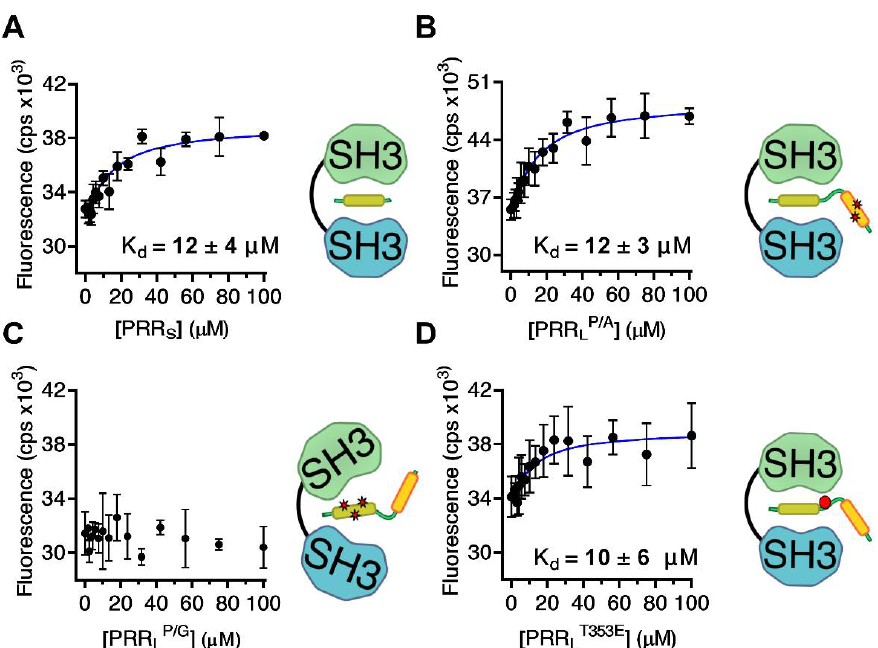
Figure 4. Binding of truncated and mutant PRR fragments to the SH3 1 –SH3 2 domain of Tks4. Dissociation constants were determined via tryptophan fluorescence-based titration experiments. PRR S ( A ) is a truncated form of PRR L . In PRR LP/A ( B ) Pro-to-Ala mutations were introduced to disrupt the second proline-rich motif (yellow box) in PRR L . (See Table 1 for sequences.) The -PPPRR- potential tandem SH3-associated motif (PTAM, green box) was intact in these variants, and they showed a K d similar to that of wild type PRR L . However, Pro-to-Gly substitutions in the PTAM core motif in PRR LP/G ( C ) totally abolished the binding to SH3 1 –SH3 2 . The phosphomimic Thr-to-Glu mutation in PRR LT353E ( D ) resulted only in a negligible change in the binding affinity. Error bars depict the S.D. of three independent measurements.